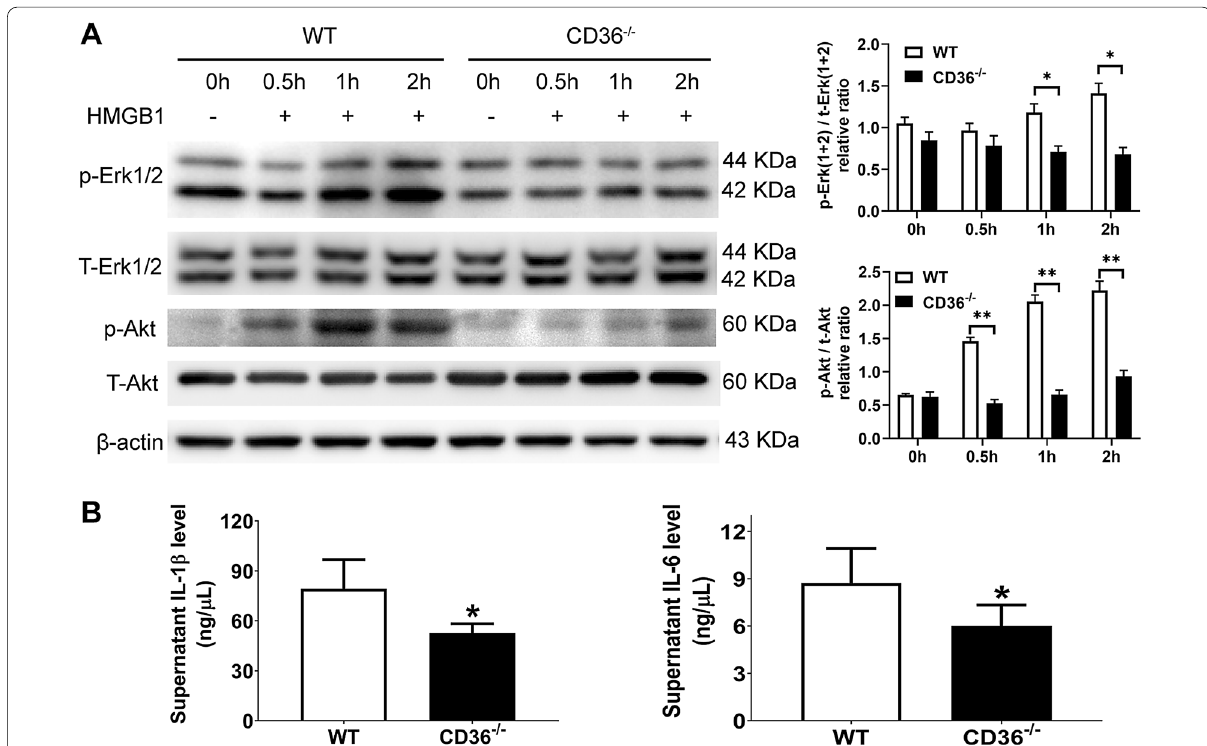
Fig.5 The effect of HMGB1 on BMDM from WT and CD36 − / − mice. BMDM were purified and treated with HMGB1 for various duration. The expression of p-Erk, total Erk, p-AKT and total AKT was examined by Western blot. The culture supernant IL-1β and IL-6 levels were measured from BMDM treated with HMGB1 for 48 h. *P < 0.05, **P < 0.01. N 4 per =